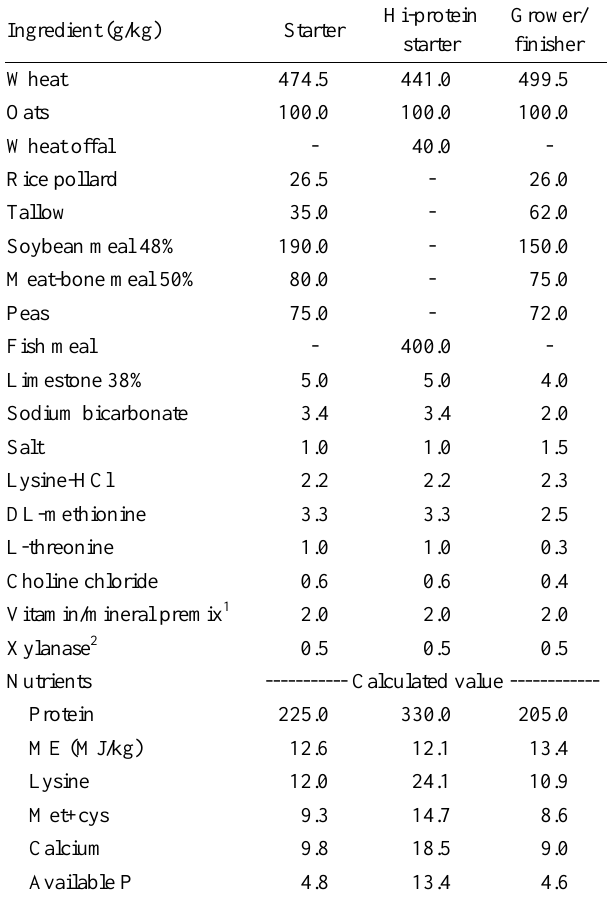
Table 1. Ingredient and composition (as-fed basis) of the basal starter, grower/finisher, and the high-protein